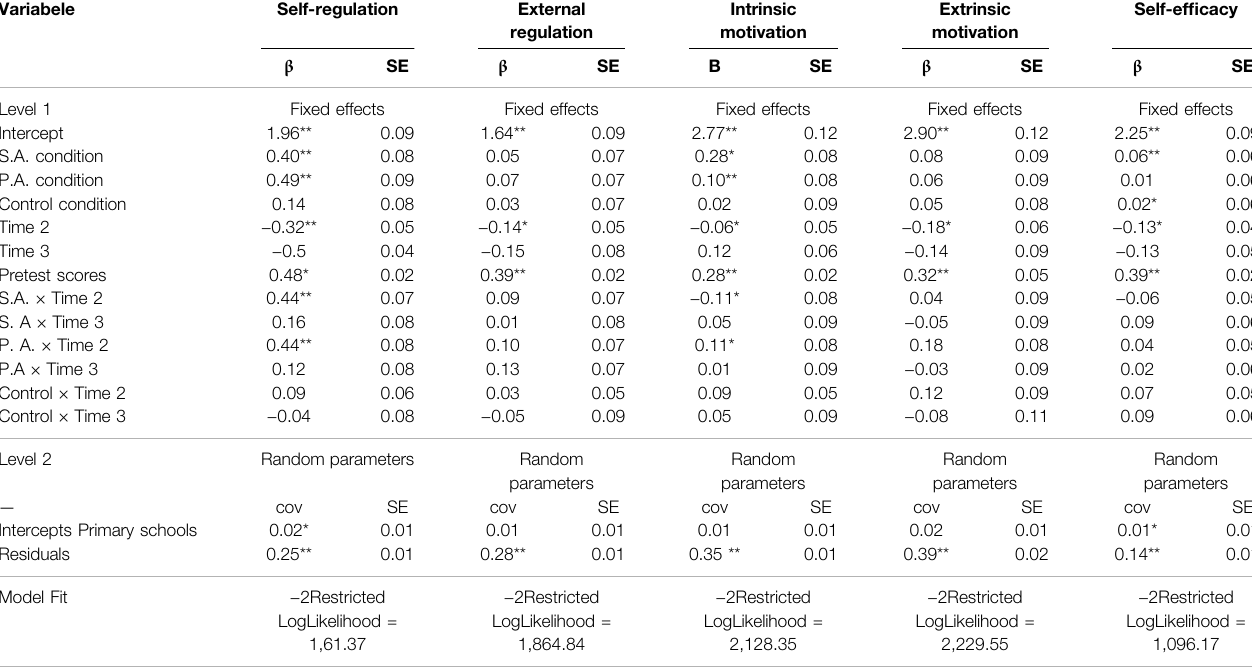
TABLE 7 | Fixed effects estimates and covariance estimates of self-regulation scores, external regulation, intrinsic motivation, extrinsic motivation and self-ef fi cacy. Variabele